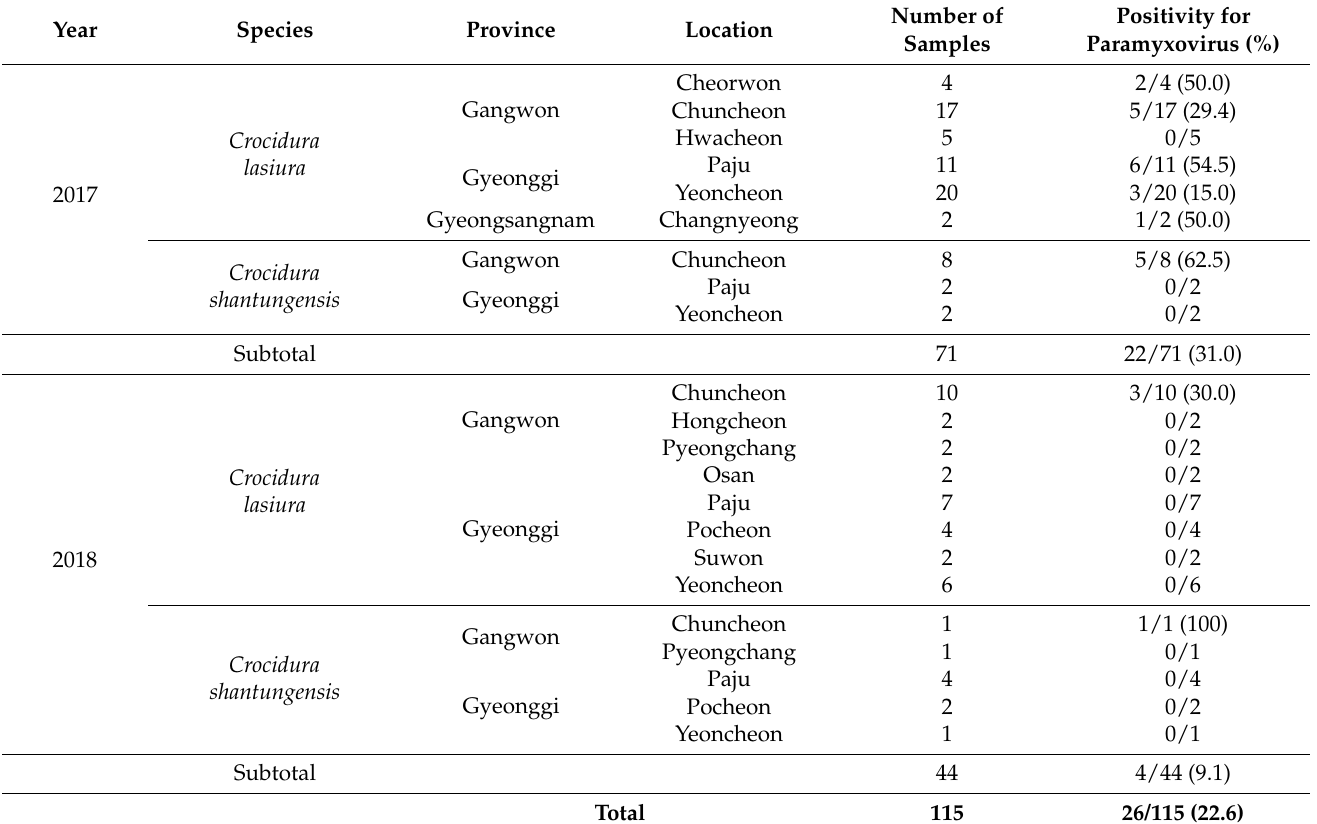
Table 1. Prevalence of paramyxovirus infections in Crocidura species individuals captured during 2017–2018, Republic of